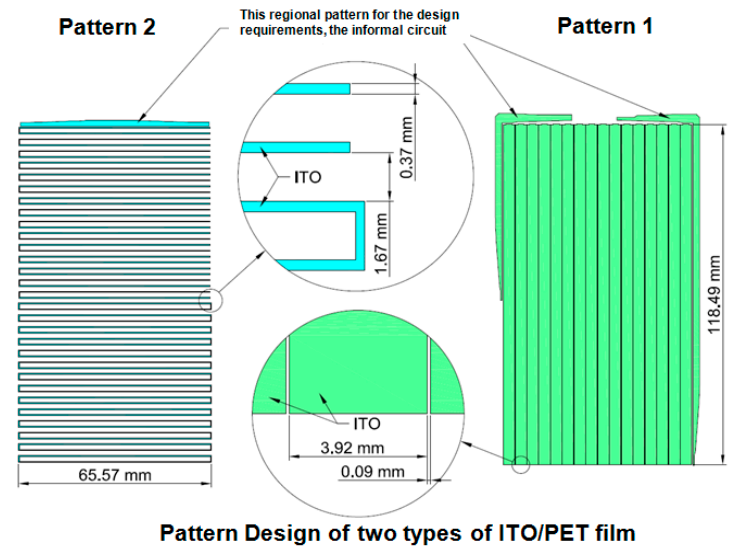
Figure 3. Top view of two types ITO/PET film specimens.